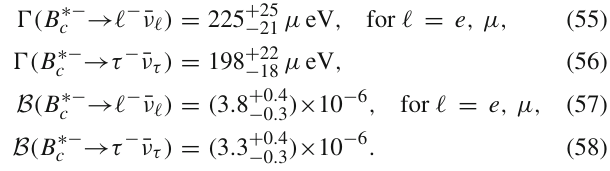
a With Martin potential model [72] b With Coulomb plus linear potential model c Obtained from the scaling relation d With the Gaussian type wave functions e With the power-law type wave functions f With Coulomb plus linear potential model g With Coulomb plus harmonic oscillator potential model h With the current quark mass i With the pole quark mass j With inputs from the inverse Laplace-type